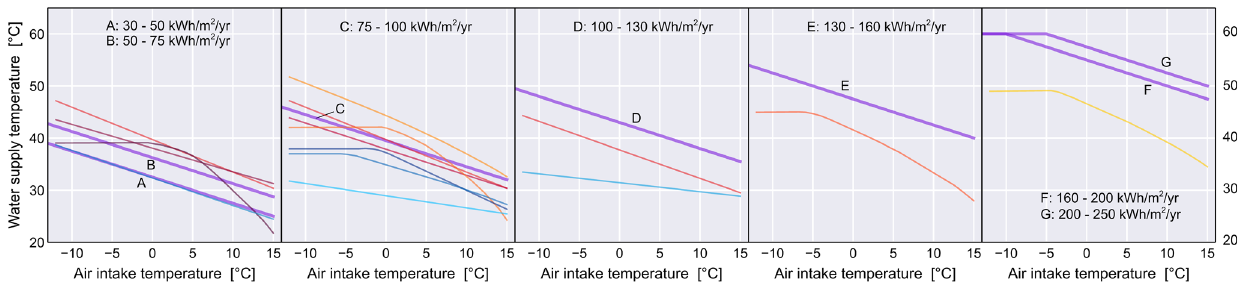
Fig. 2 Water temperature of heat pumps in buildings with different insulation levels. Thin lines: Measured water supply temperature of the heating circuit as a function of outdoor intake temperature of the heat pump 31 . Only circuits with radiators are considered. The supply temperature varies among buildings having the indicated energy ef fi ciency (building insulation) from A to G, which is indicated as the range of the speci fi c heating energy. Bold lines: Our linear fi t for the model. For poorly insulated budlings, it is conservative to consider rather inef fi cient heating circuits. Data are listed in